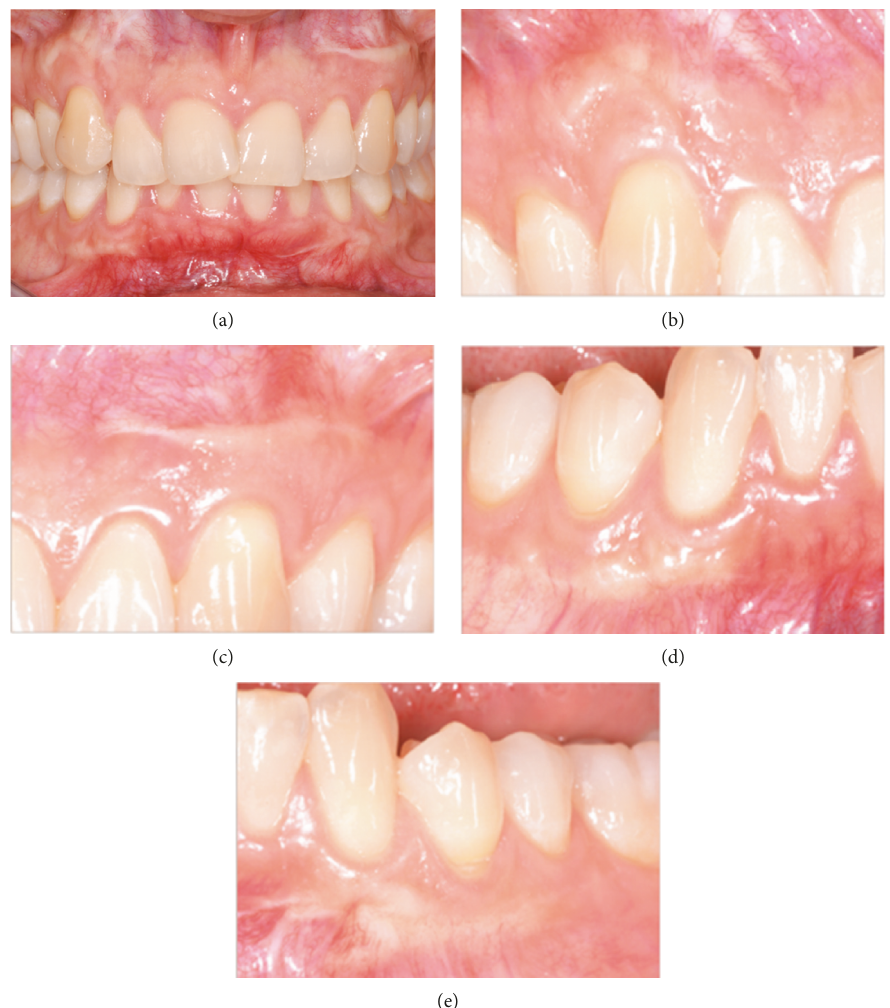
Figure 2: Clinical situation 4 years after the last surgical intervention. In the absence of gingival overgrowth, formation of thin scars is